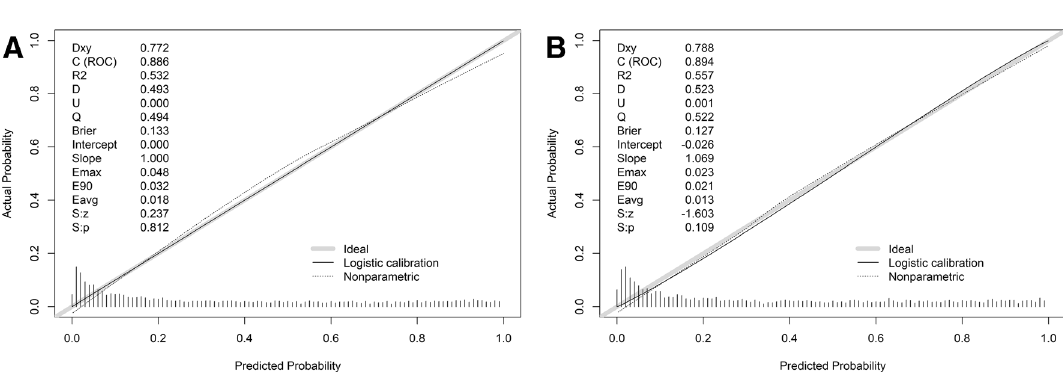
Figure 5. Calibration curves in the development set ( A ) and the validation set ( B